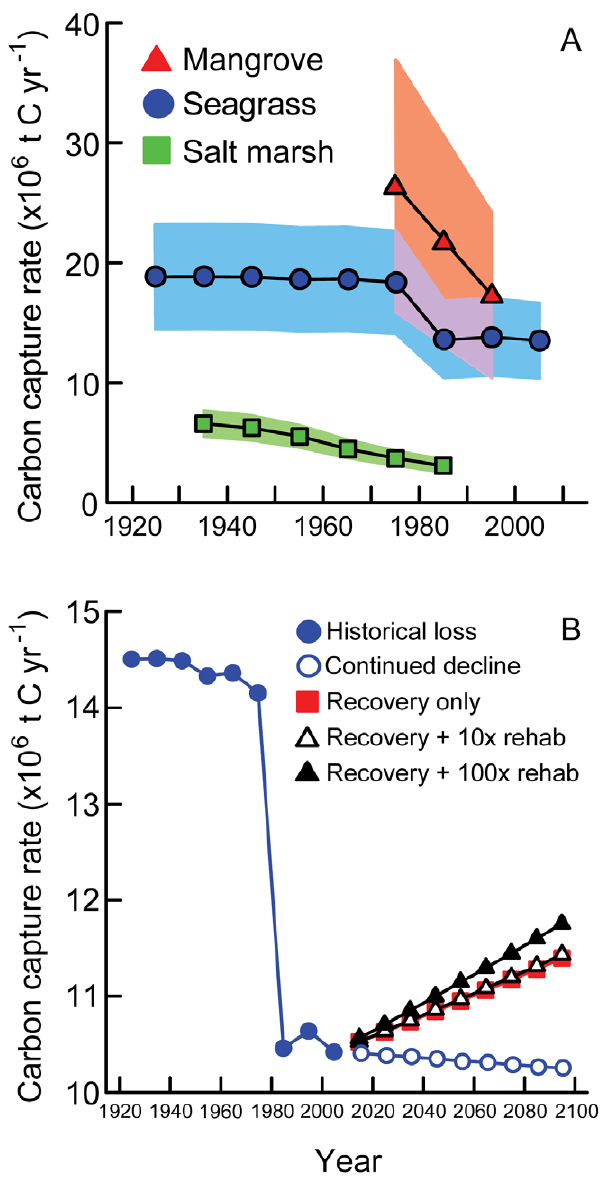
Figure 2. Historical and future carbon capture and storage rates (CCS) of coastal vegetation. (A) Extensive historical losses of seagrasses, mangroves, and salt marshes have reduced the CCS capacity of the coast. Points plotted represent the mean CCS for each habitat over time, and are bounded by lines of maximum and minimum rates of CCS published in the literature. Note that minimum rates for mangroves overlaps with the range of values for seagrass (depicted with purple shading). (B) Historical rates of CCS by seagrass are compared to rates under future scenarios of natural habitat recovery, as well as recovery combined with different intensities of restoration. Increasing restoration efforts to 100-times current levels will produce benefits to CCS that are similar to natural recovery alone. Rates of CCS following current trends in continued global seagrass decline are also plotted for reference. Data for calculating CCS rates were primarily sourced from [8,9,12,13,15,16,34] (also see Table 1).